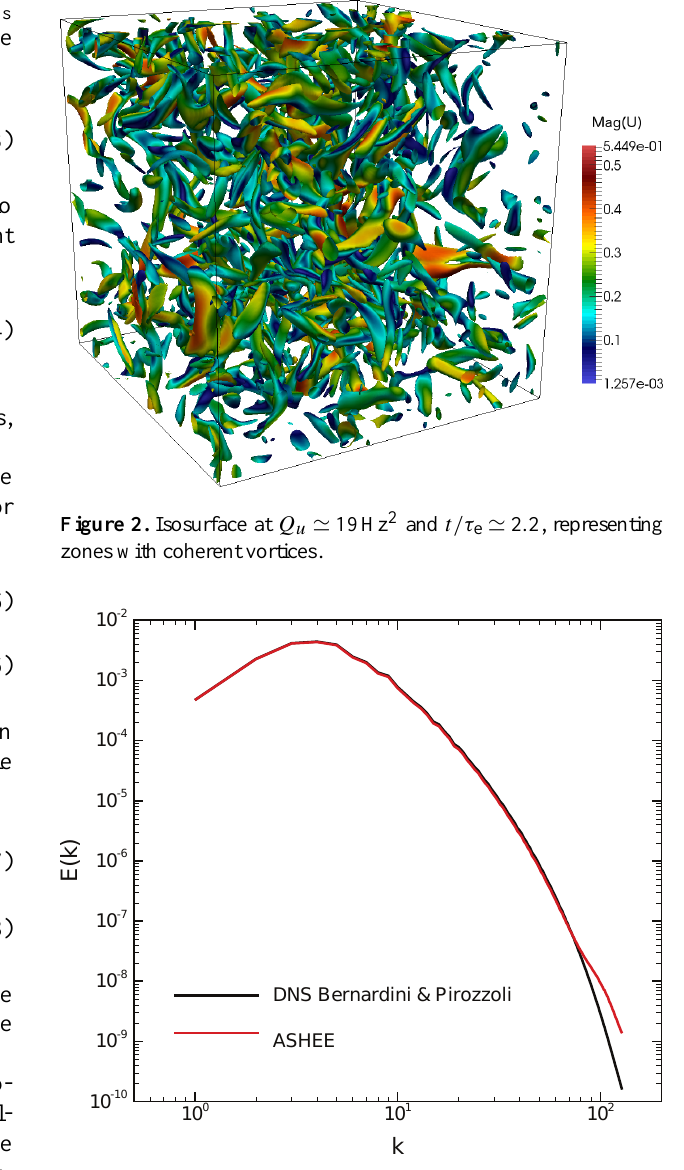
Figure 3. Comparison of a DNS executed with the eight order scheme by Pirozzoli and Grasso (2004) and our code implemented using the C++ libraries of OpenFOAM ® at t/τ e = 1 . 093. The L 2 norm between the two spectra is 4 . 0 × 10 − 4 . The main parameters are Re λ (cid:39) 116, Ma rms = 0 .